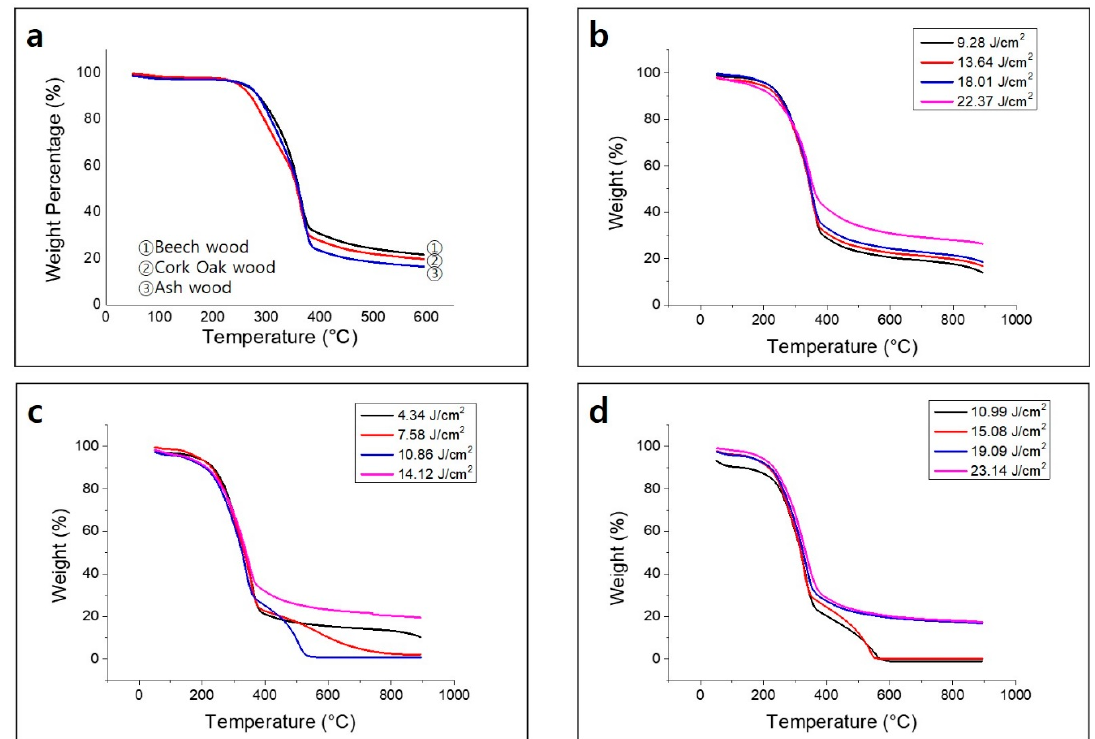
Figure 7. Thermogravimetric analysis (TGA) of ( a ) beech, cork oak, and ash wood and biochar derived from ( b ) beech, ( c ) cork oak, and ( d ) ash wood.